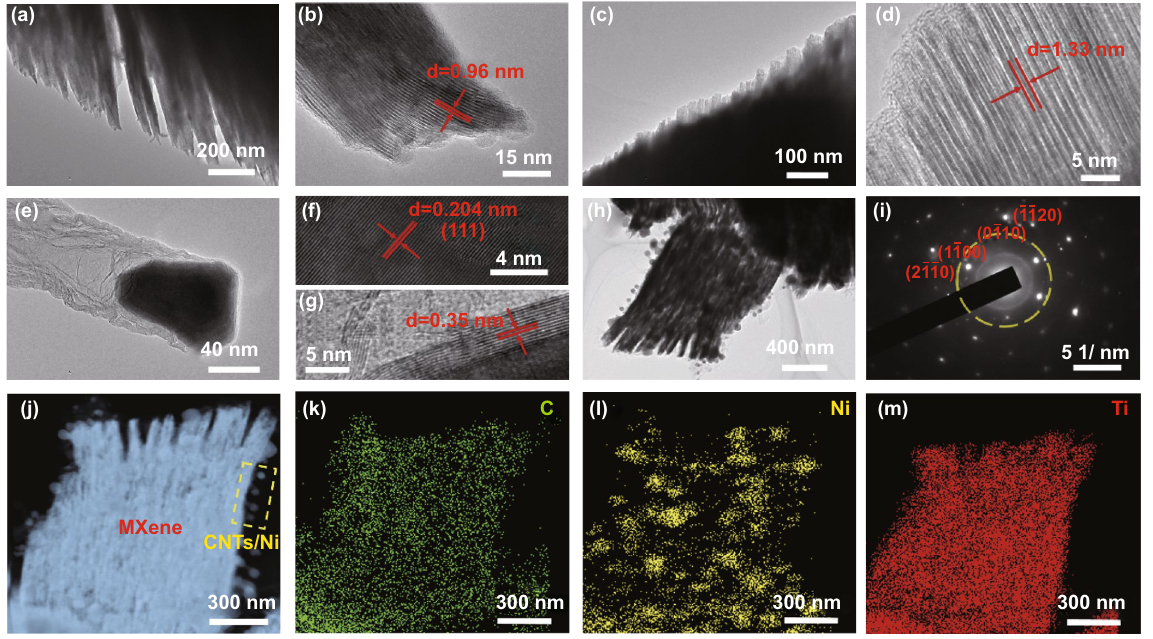
Fig. 3 TEM images of a MXene, c MXene-alk, e CNTs/Ni and h MXene-CNTs/Ni composites. HRTEM images of b MXene, d MXene-alk, f Ni and g CNTs. STEM images of j–m MXene-CNTs/Ni and corresponding elemental mapping of C, Ni, and